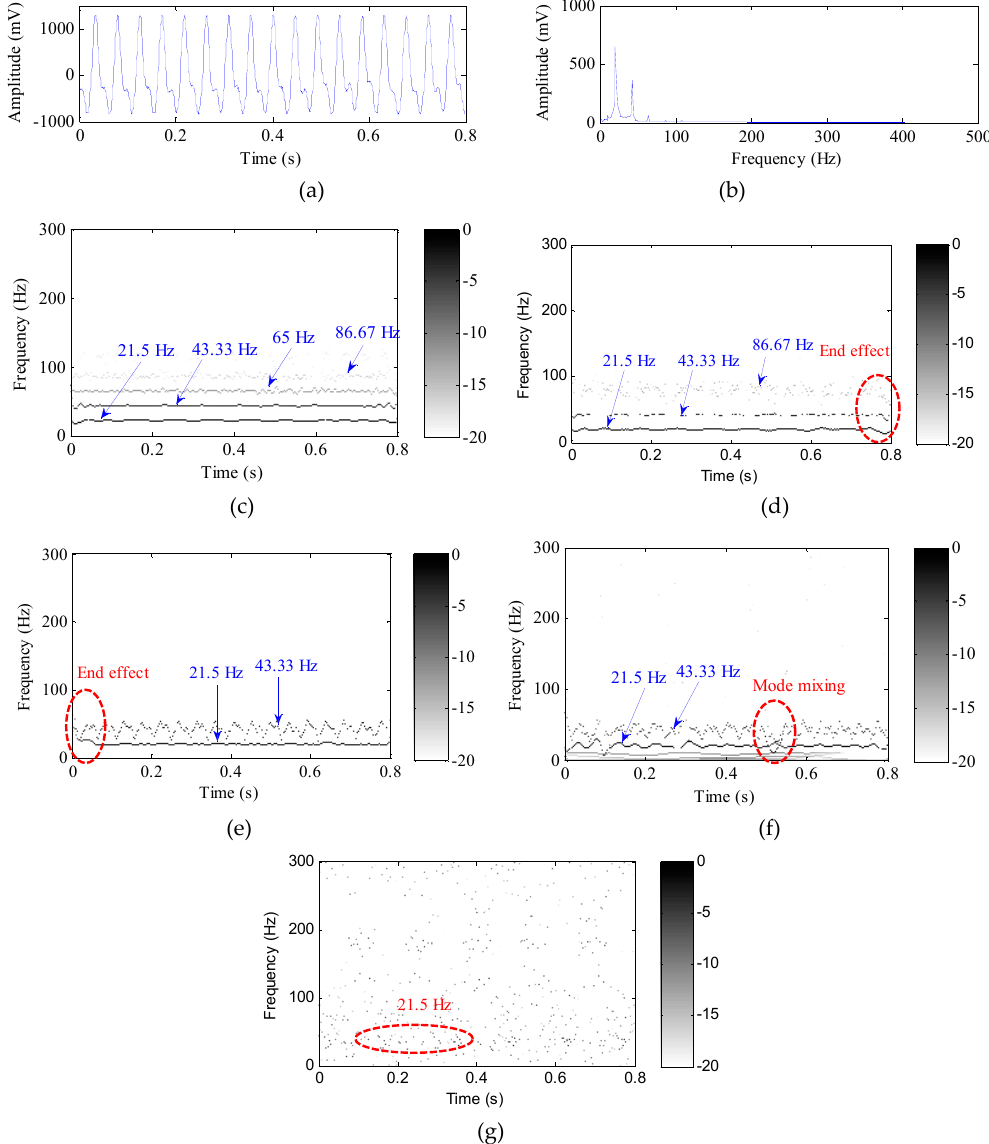
Figure 19. The analyzed results of the rotor oil-whirl signal: ( a ) Temporal waveform, ( b ) FFT spectrum, time-frequency representations obtained by ( c ) IAVMD, ( d ) OVMD, ( e ) LMD, ( f ) EMD, and ( g ) WT.